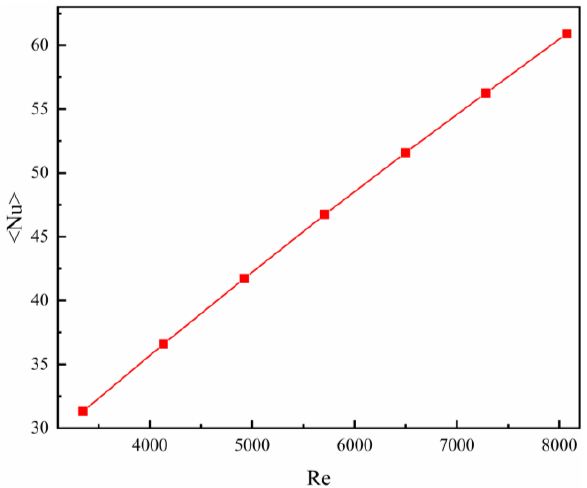
Figure 16. Distributions of Nusselt number versus Reynolds numbers.